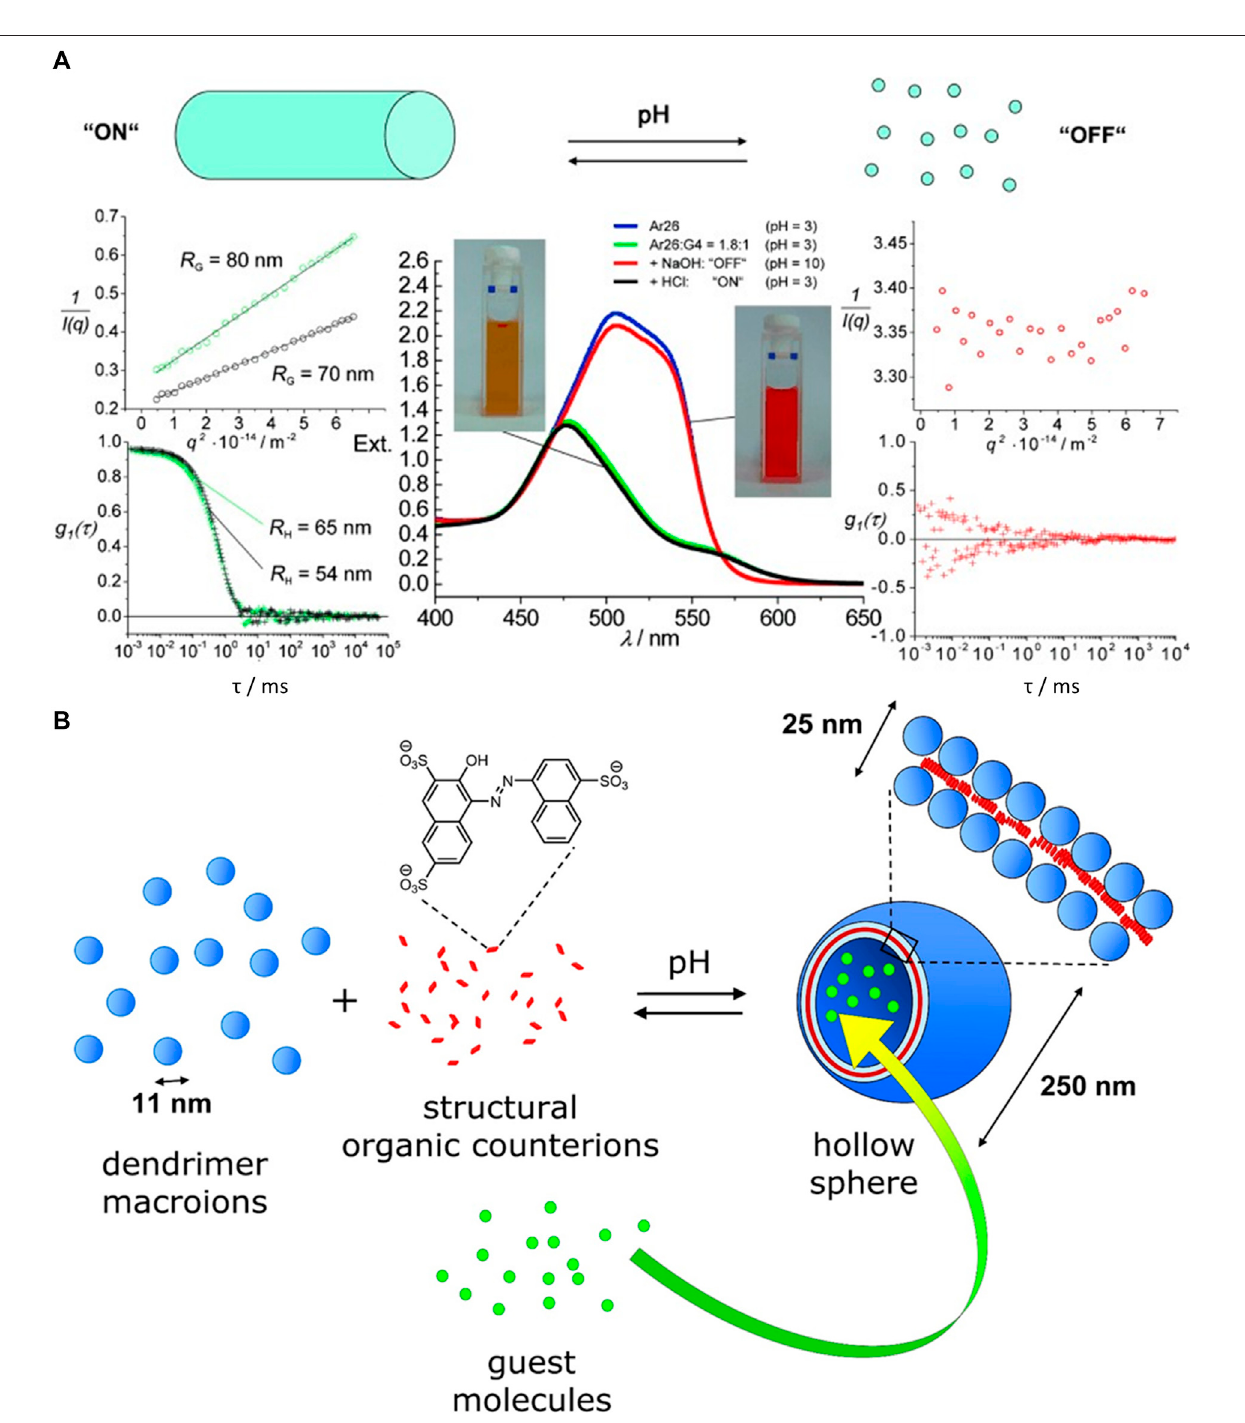
FIGURE 17 | Switching “ on ” and “ off ” of electrostatically self-assembled structures by pH: (A) G4-Ar26 assemblies: “ on ” and “ off ” means aggregates and single dendrimers, respectively; center: UV/Vis spectra; left and right, static and dynamic light-scattering (Willerich and Gröhn, 2008), (B) Capsule formation and pH on-off switching of G8 dendrimer with Ar27 (Gröhn et al., 2010). Reprinted with permission. Copyright © 2008 and 2010 WILEY-VCH Verlag GmbH, Co. KGaA, Weinheim and The Royal Sociaty of Chemistry.